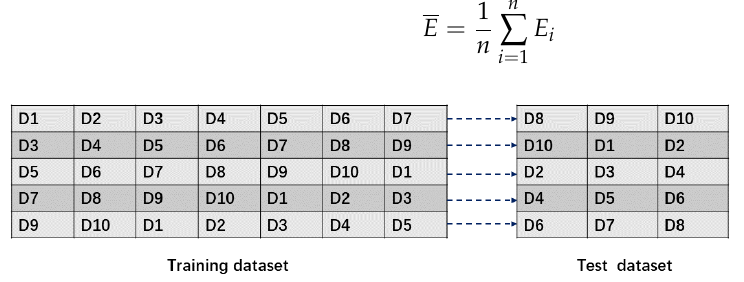
Figure 8. Schematic diagram of the cross-validation experiment. The ratio of training set to test set is 7:3, and k-fold cross-validation is performed, k = 5.